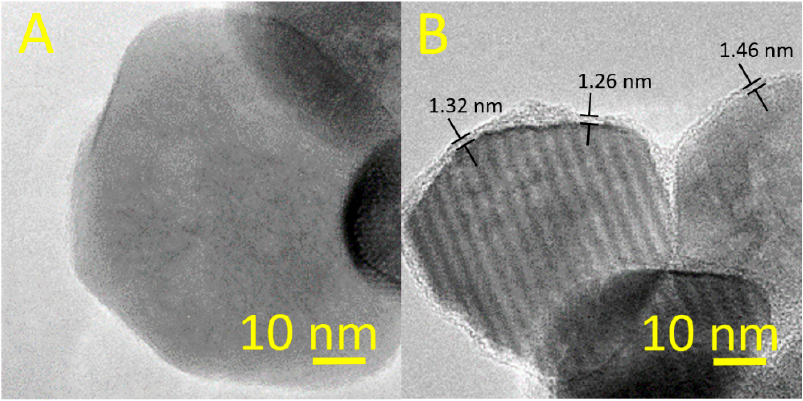
Figure 2. SEM observation of α -Fe 2 O 3 NPs prepared with different concentrations of Fe (III) ni- trate, ( A ) 0.05 M ( α -Fe 2 O 3 - p 45), ( B ) 0.1 M ( α -Fe 2 O 3 - p 70), and after ɑ -Fe 2 O 3 NPs coating with the citrate, ( C ) 0.05 M ( α -Fe 2 O 3 - n 45), ( D ) 0.1 M ( α -Fe 2 O 3 - n 70).